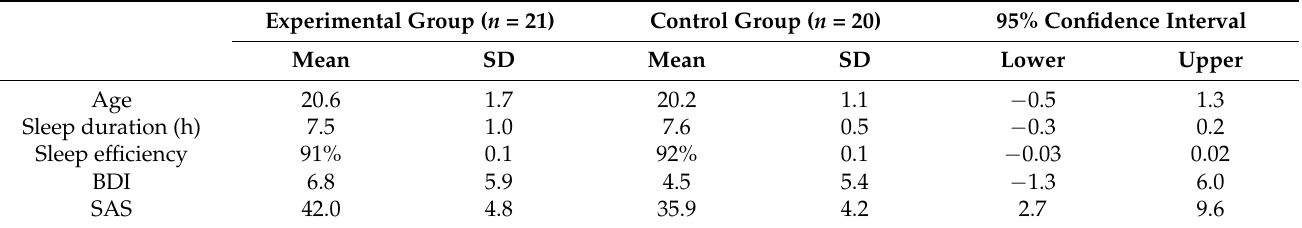
Table 1. Participant